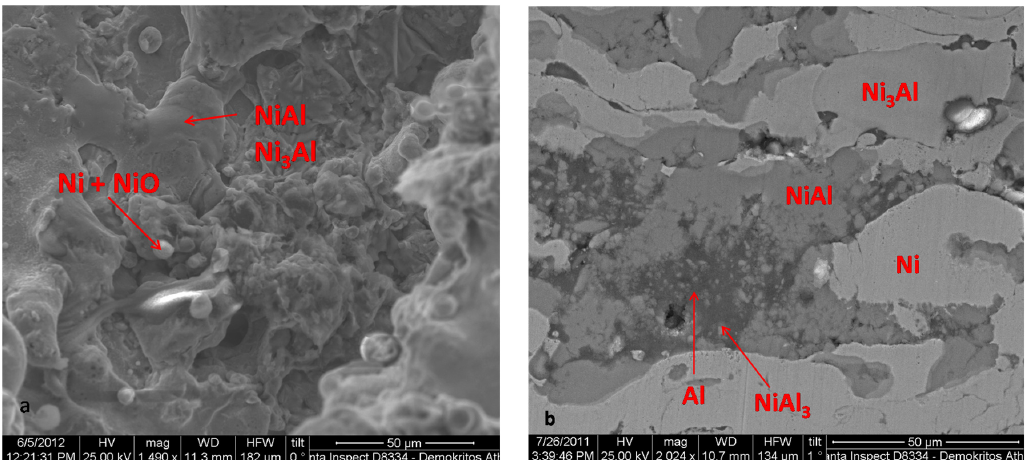
Figure 6. SEM/EDX analysis of the specimen RB ‐ Ni65 ‐ 1 of ( a ) surface of the catalytic coating and ( b ) a cross ‐ section of the coating.